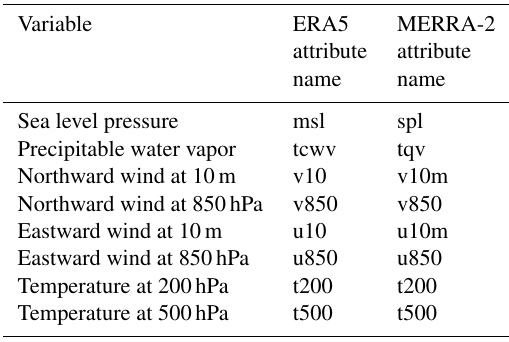
Table 2. Dataset